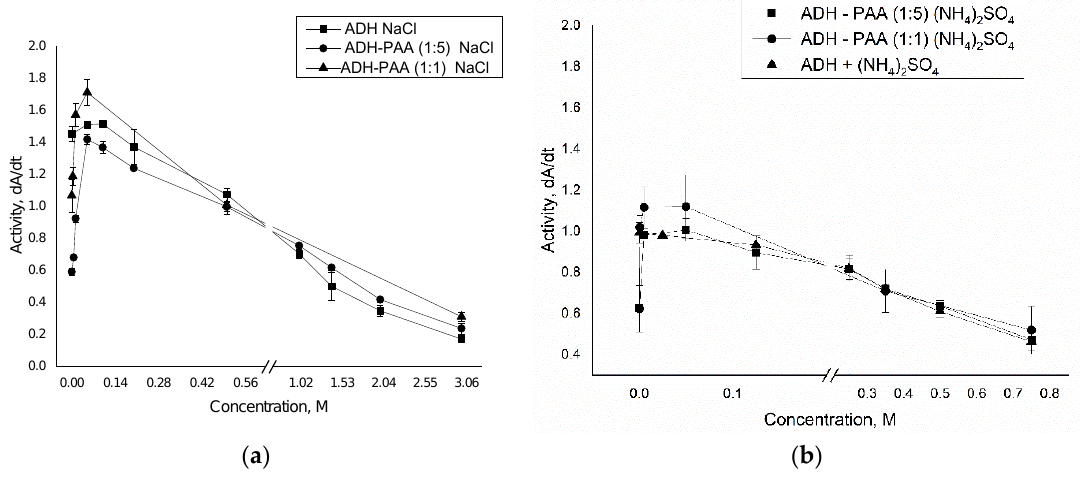
Figure 3. Dependence of ADH activity (6.25 µg / ml) in the native state and in the presence of PAA (6.25 µg / ml, 1: 1; 31.25 µg / ml, 1: 5) on the concentration of sodium chloride ( a ) and ammonium sulfate ( b ).